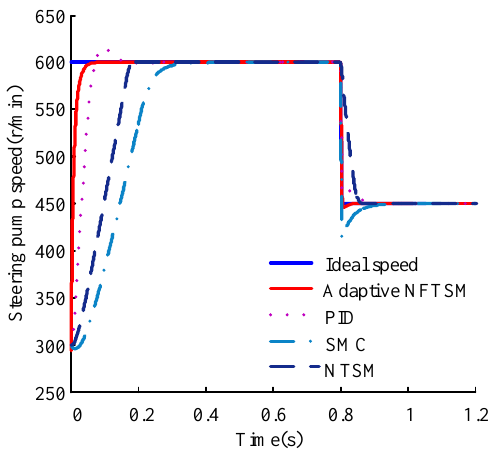
Figure 13. Speed response when target speed is changed.